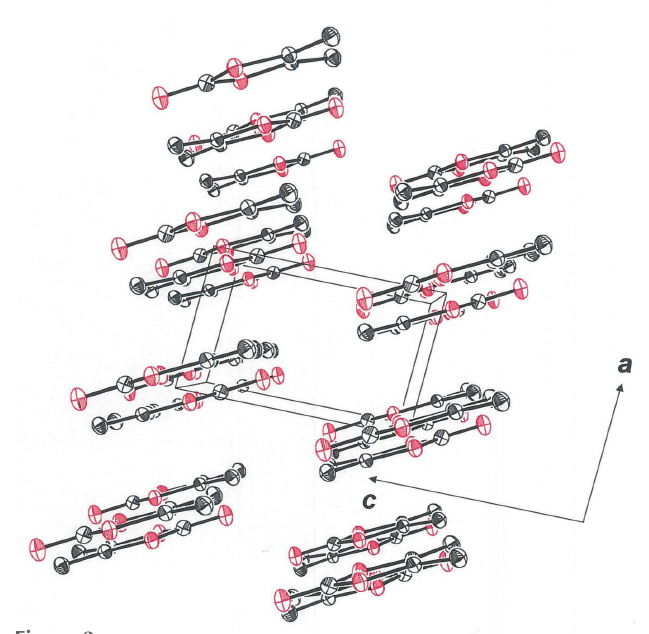
Figure 1 Displacement ellipsoid plot (50% probability) of 4,5-dimethyl-1,3-dioxol- 2-one ( 1 ) with non-H atom